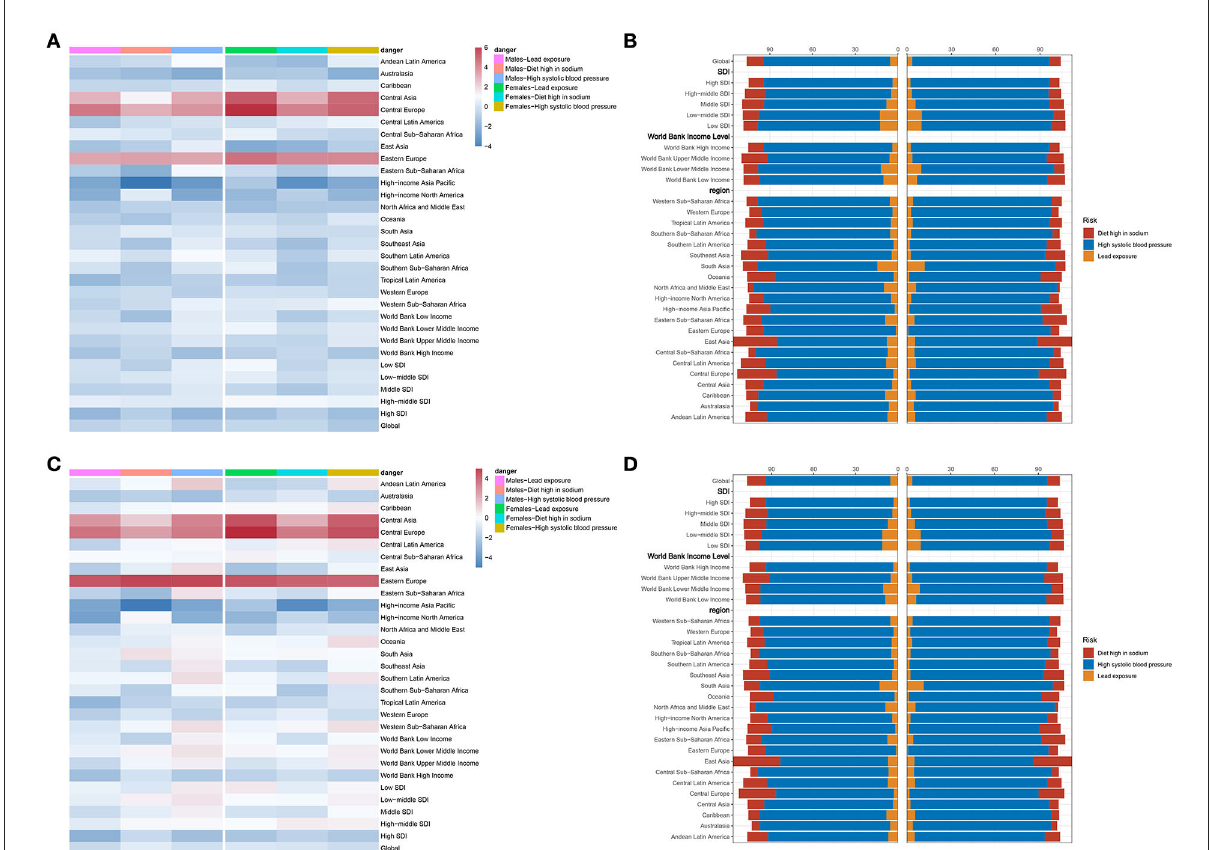
FIGURE5 Attributable risks of CAVD. (A) EAPC and attributable risks of ASDR in 31 regions. (B) PAF of attributable risks of ASDR in 2019. (C) EAPC and attributable risks of ASDALYR in 31 regions. (D) PAF of attributable risks of ASDALYR in 2019. CAVD, calcific aortic valve disease; EAPC, estimated annual percentage change; ASDR, age-standardized death rate; PAF, population attributable fraction; ASDALYR, the age-standardized disability-adjusted life years